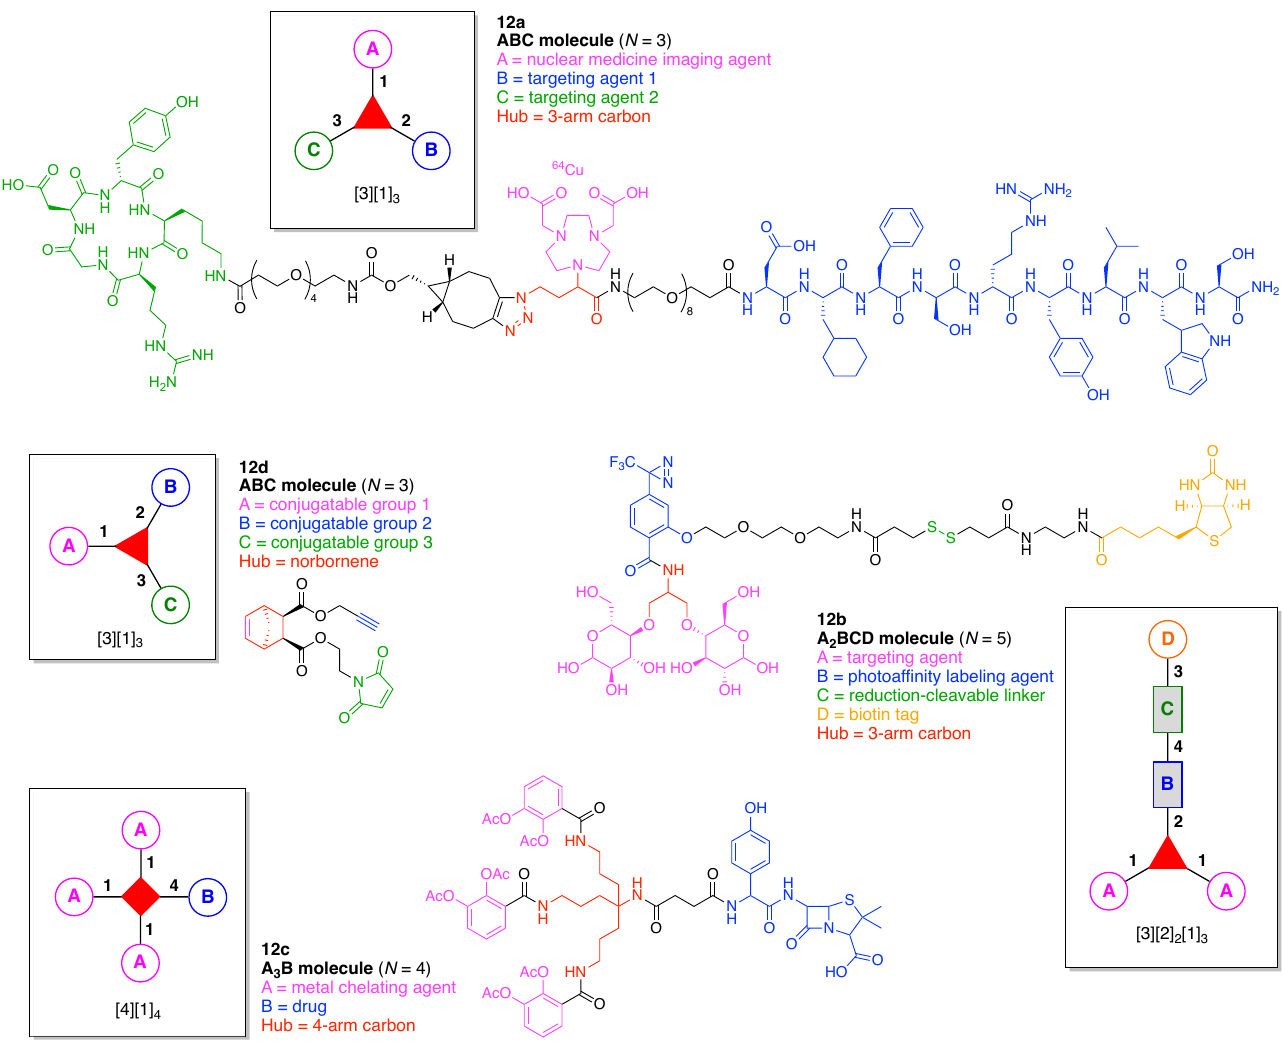
Figure 59. Examples wherein each contains a single carbon hub. The key design of 12d was based on the requirement of three different functional groups wherein each corresponding click reaction can be performed without any cross- reaction. As shown in Figure 60, maleic anhydride ( 12d-1 ) was first treated with cy- clopentadiene [297] to give 12d-2 followed by propargyl alcohol to give the ring-opened difunctionalized intermediate 12d-3 . In a separate route, 12d-1 was reacted with furan to give the Diels–Alder product 12d-4 , which upon reaction with 2-aminoethanol gave 12d-5 , which underwent thermal retro-Diels–Alder to give furan N -2-hydroxyethylmaleimide 12d-6 [298]. The final attachment was completed by esterification to join 12d-3 and 12d-6 . The resulting scaffold 12d is amenable to one-flask reaction of the three aforementioned click reactions without any further protection technology or extra purification steps, which hints at attractive future designs as long as the reactions conditions and sequence are duly considered. Three different macromolecular segments now can be introduced simultane- ously to impart complexity in the target